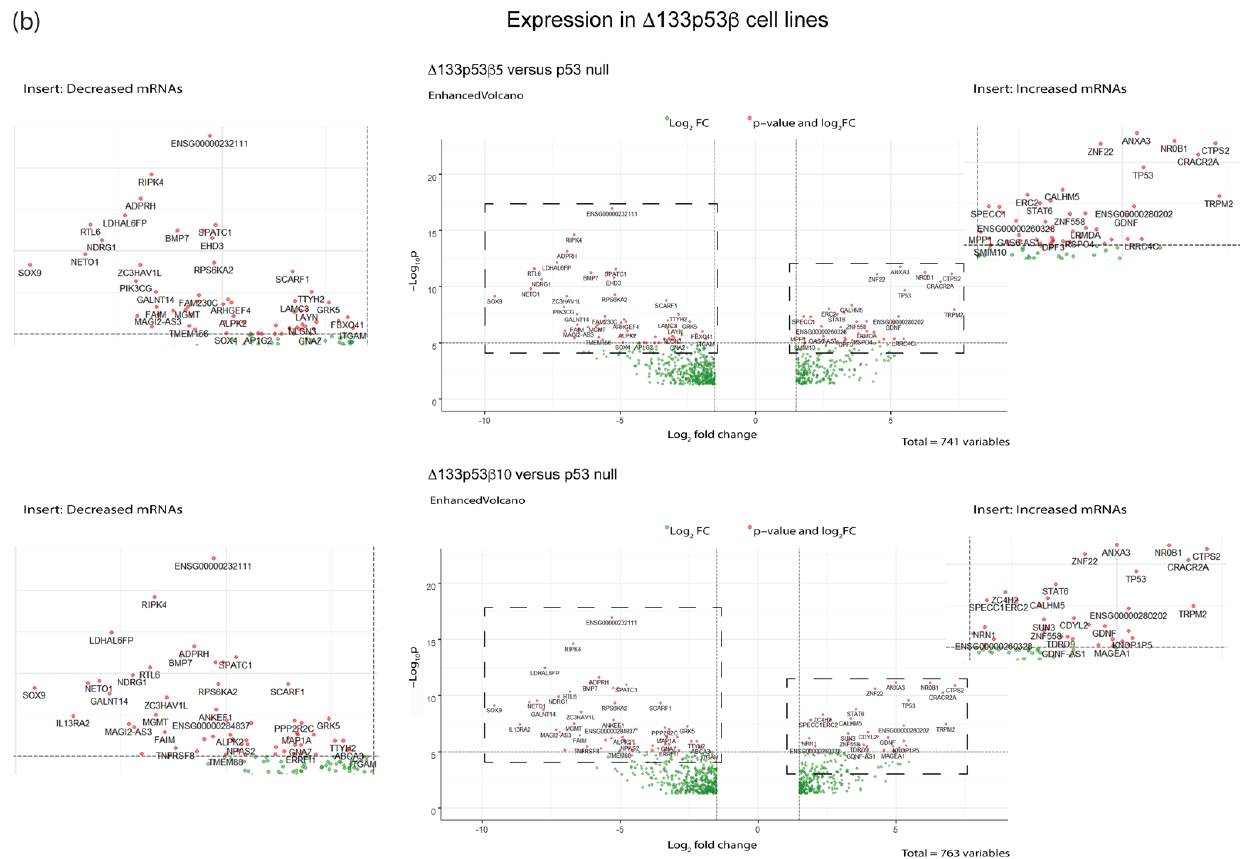
Figure 5. Volcano plots of gene transcripts altered in ∆ 133p53 α or ∆ 133p53 β cells compared with the control (p53 null). ( a ) Transcripts increased and decreased in ∆ 133p53 α cell lines and ( b ) transcripts increased and decreased in ∆ 133p53 β cell lines. Transcripts highlighted in red were considered statistically differentially expressed (criteria of false discovery rate (FDR) < 0.05 and log 2 fold change of ±1.5 (FC ± 1.5)). Boxed areas shown as inserts to the left and right.